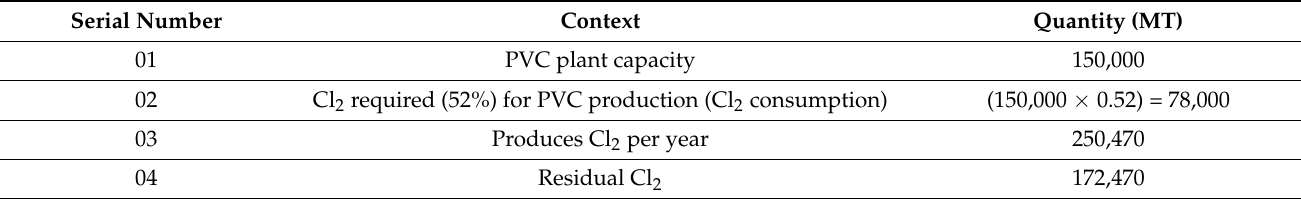
Table 5. Calculations for Meghna PVC plant Cl 2